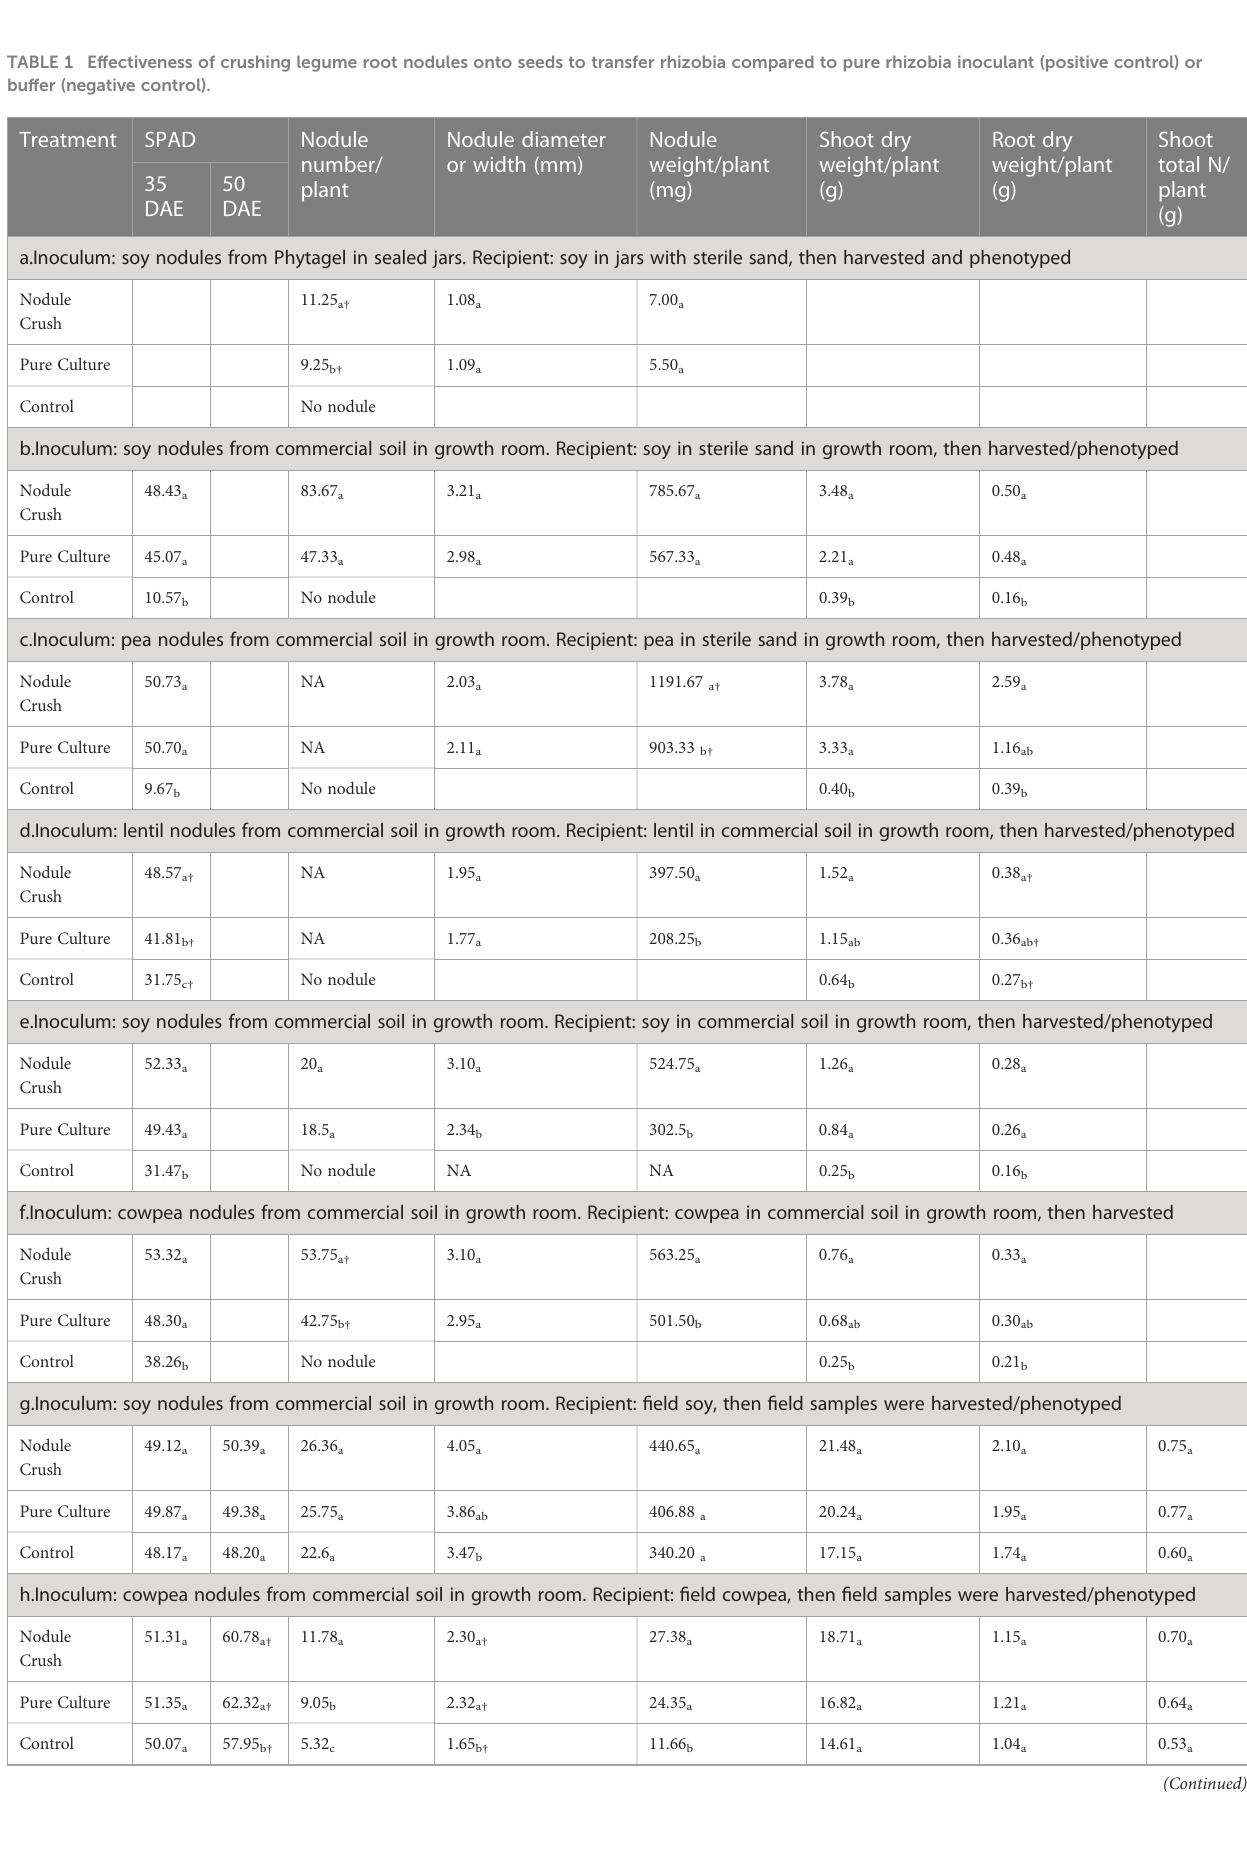
TABLE 1 Effectiveness of crushing legume root nodules onto seeds to transfer rhizobia compared to pure rhizobia inoculant (positive control) or buffer (negative control). Treatment SPAD Nodule